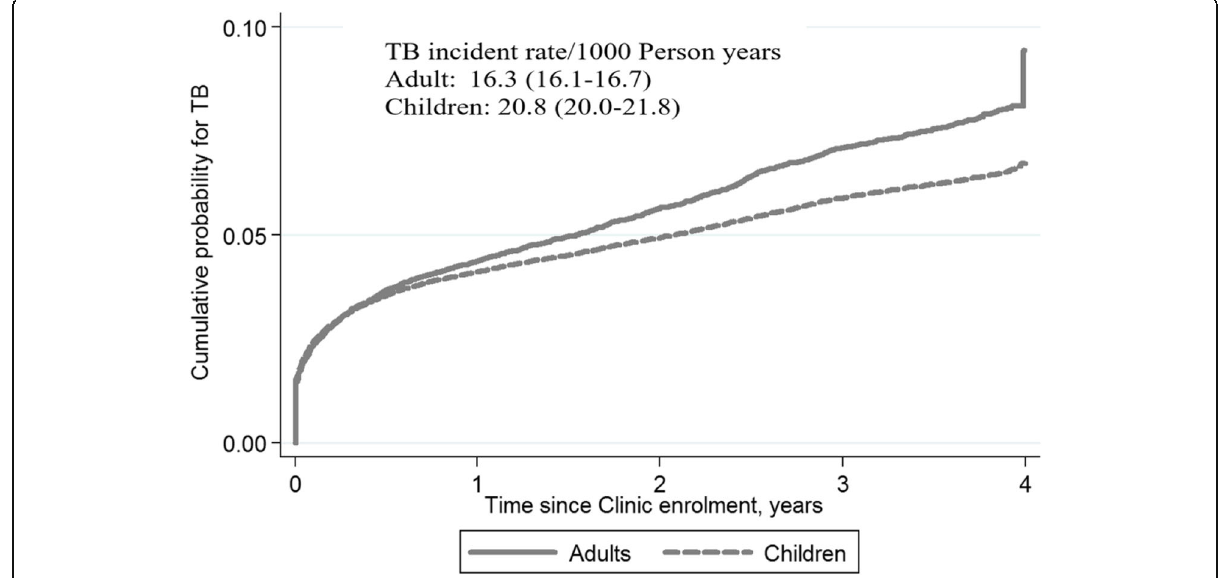
Fig. 2 Cumulative probability of TB incident after enrollment to HIV care and treatment by